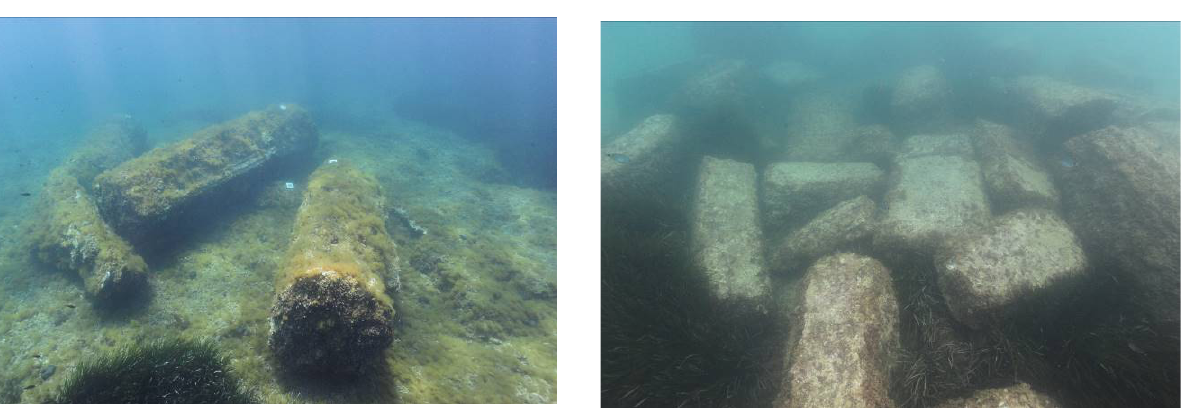
Figure 1. Marzamemi shipwreck. Detail of the columns. (photo: Figure 3. Cape Granitola shipwreck. (photo: D. Della D. Della Libera)